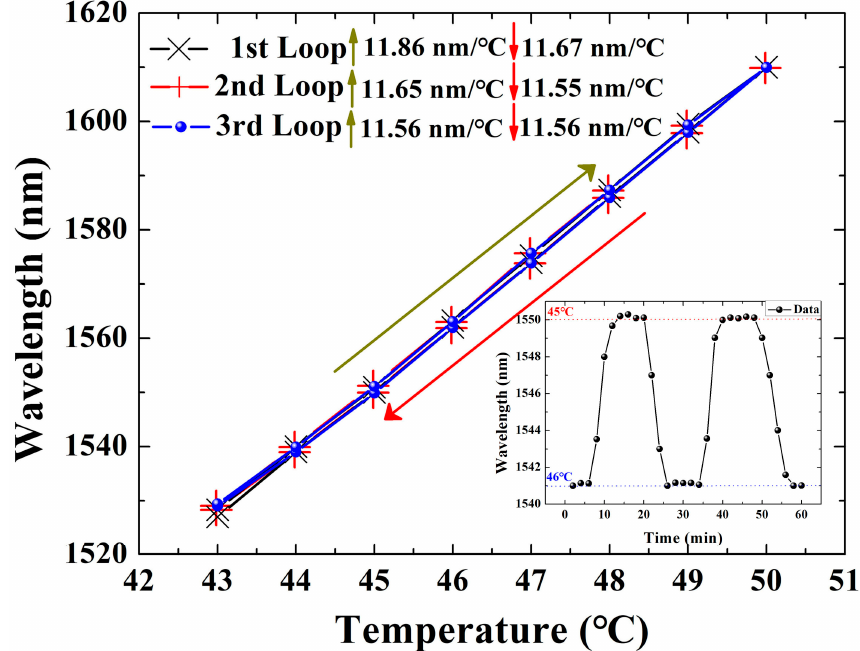
Figure 6. Three-cycle experiments for the temperature-dependence curves for a Fabry-Perot interferometer with the cavity length of 31 μ m and the microfiber diameter of 61 μ m. Inset: Stability of the wavelength locations for the temperature changing between 45 °C and 46 °C.